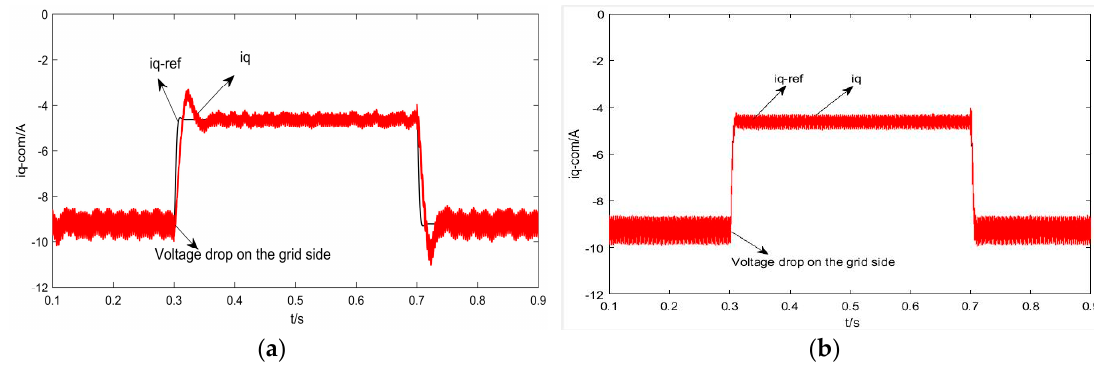
Figure 14. Reactive current tracking curves when using different controls. ( a ) Reactive current tracking curve in traditional LADRC control, ( b ) reactive current tracking curve in improved LADRC control.